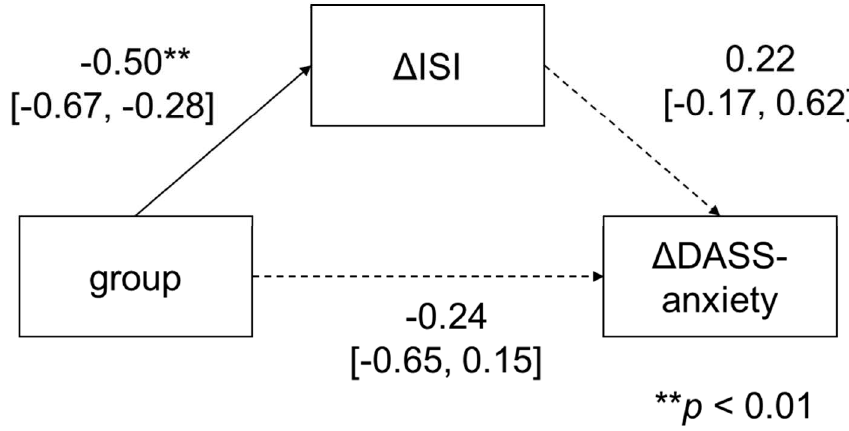
Figure 2. Mediation analysis of DASS-depression .